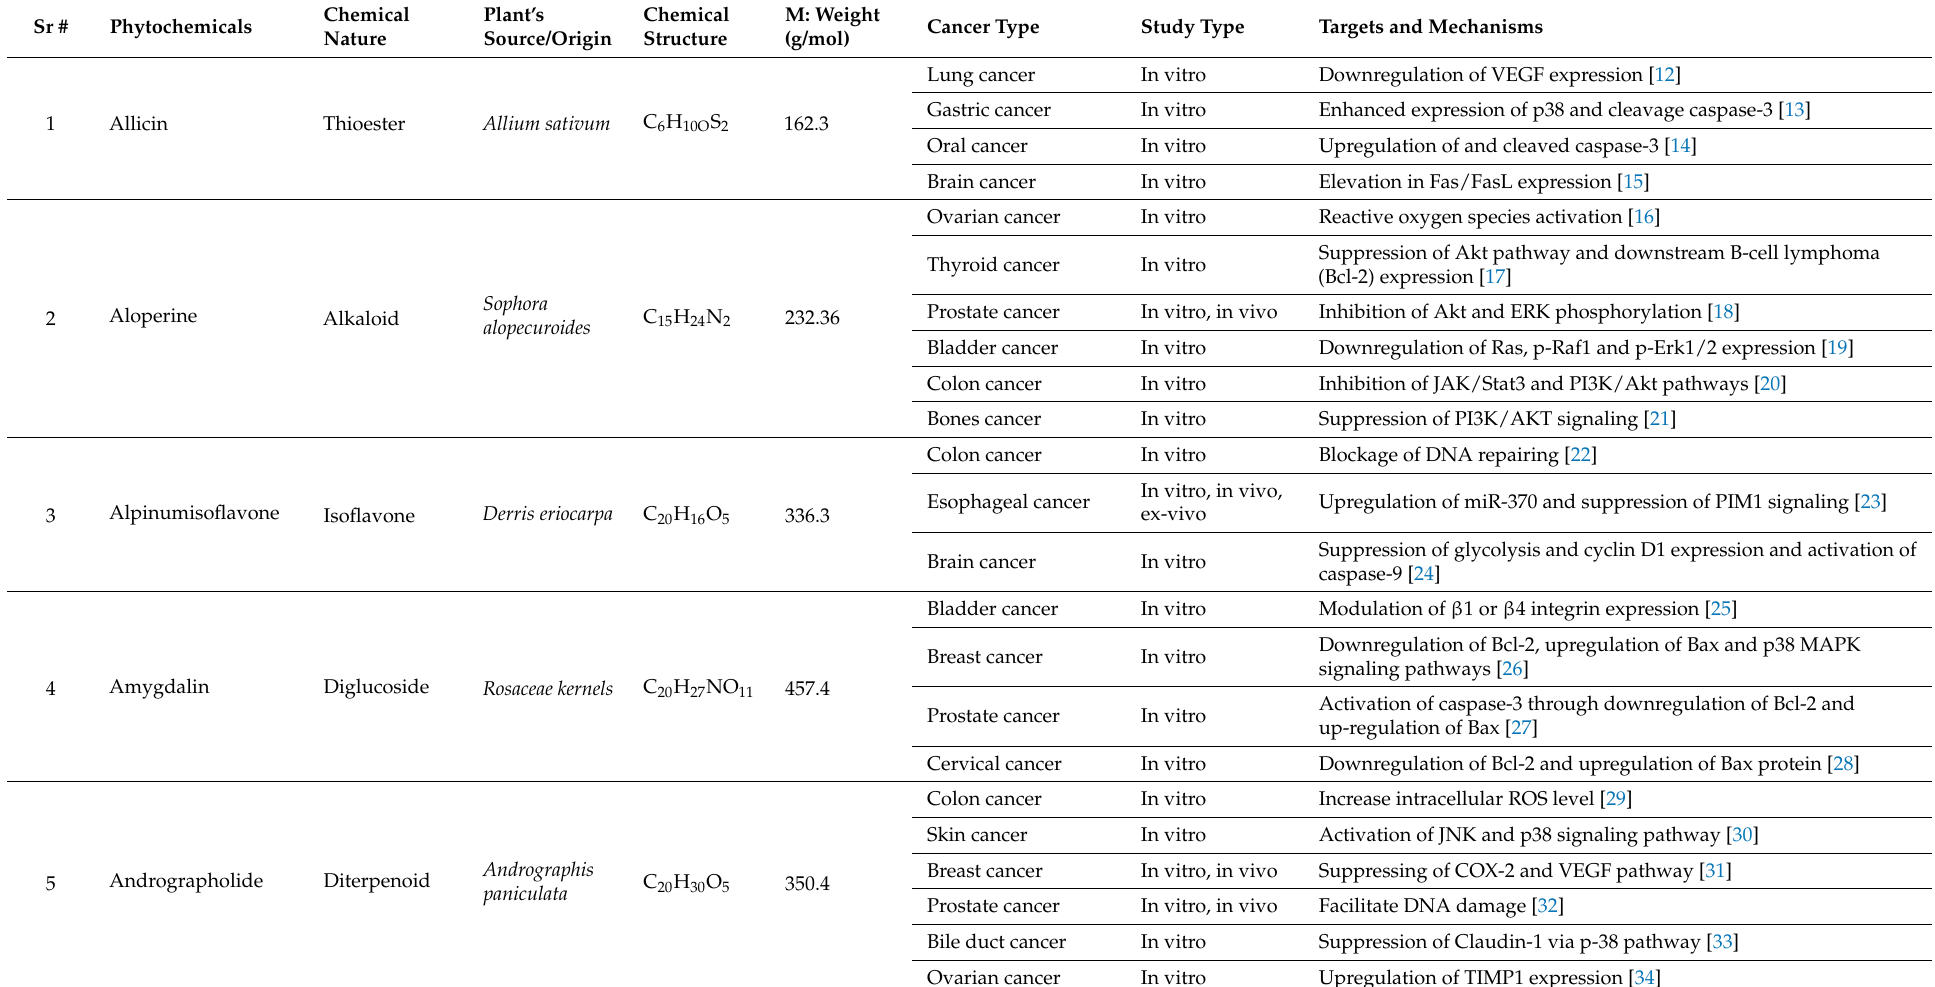
Table 2. Plant-derived phytochemicals with potential anticancer properties, and their mechanisms of